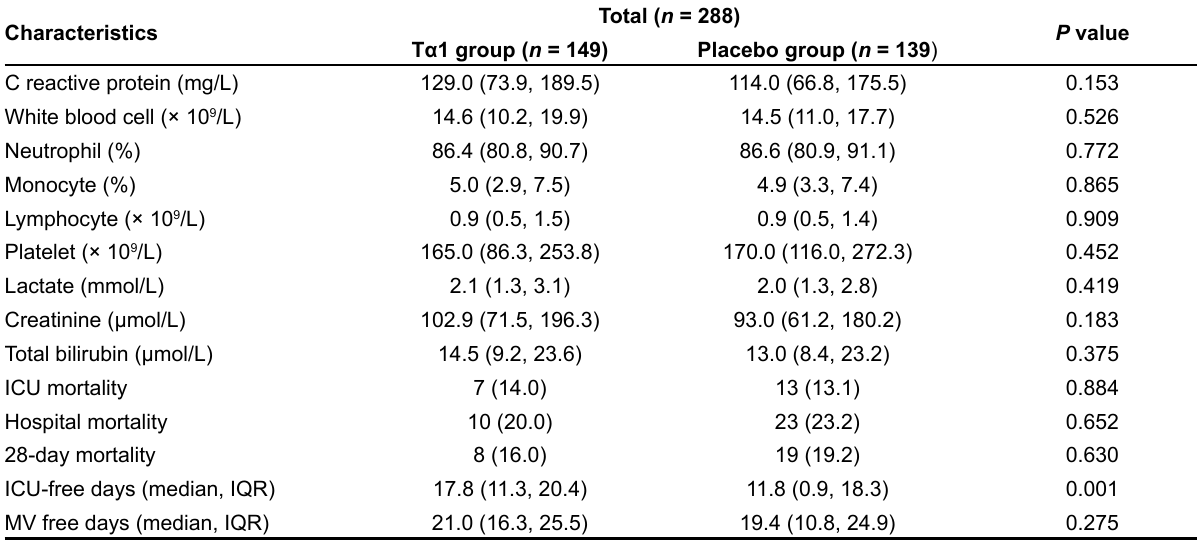
Table 1. Baseline clinical characteristics of patients with sepsis ( continued )